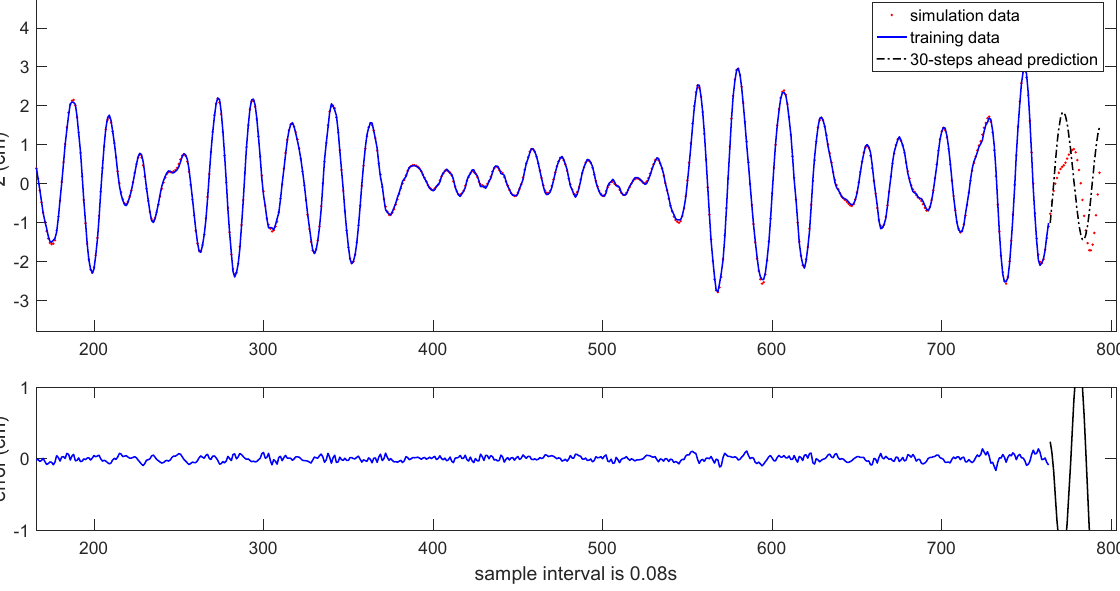
Figure 20. The 30-steps-ahead prediction of heave motion in irregular waves at the instant k = 763 for the FPSO model.